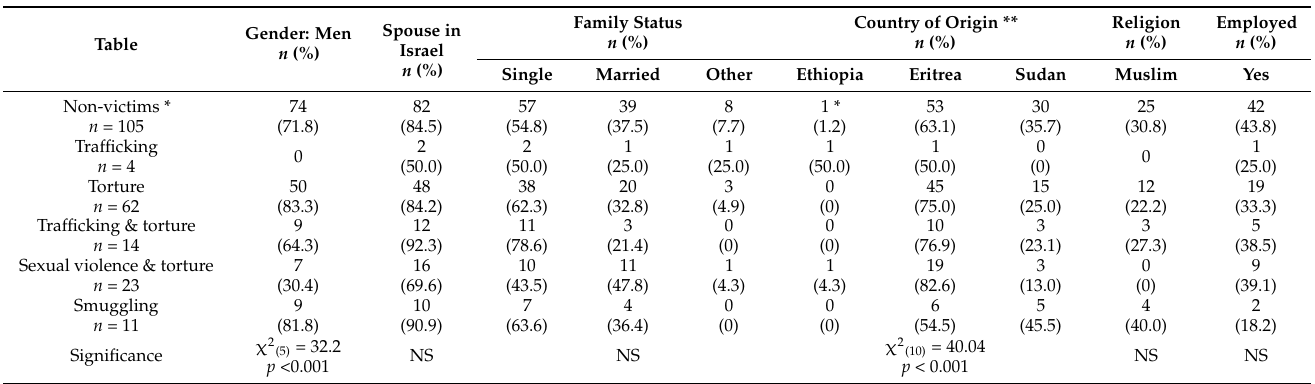
Table 2. Demographic variables of asylum seekers who experienced different types of trauma in the Sinai Peninsula, and non-trauma